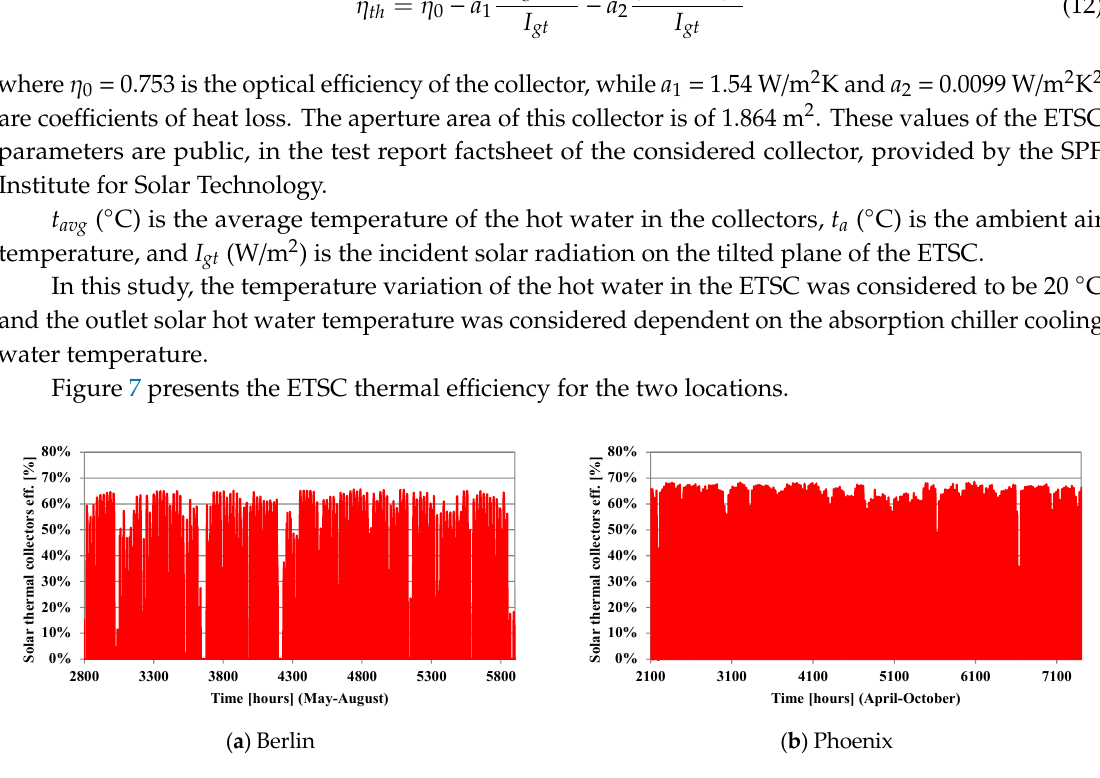
Figure 7. ETSC thermal efficiency for the two locations.